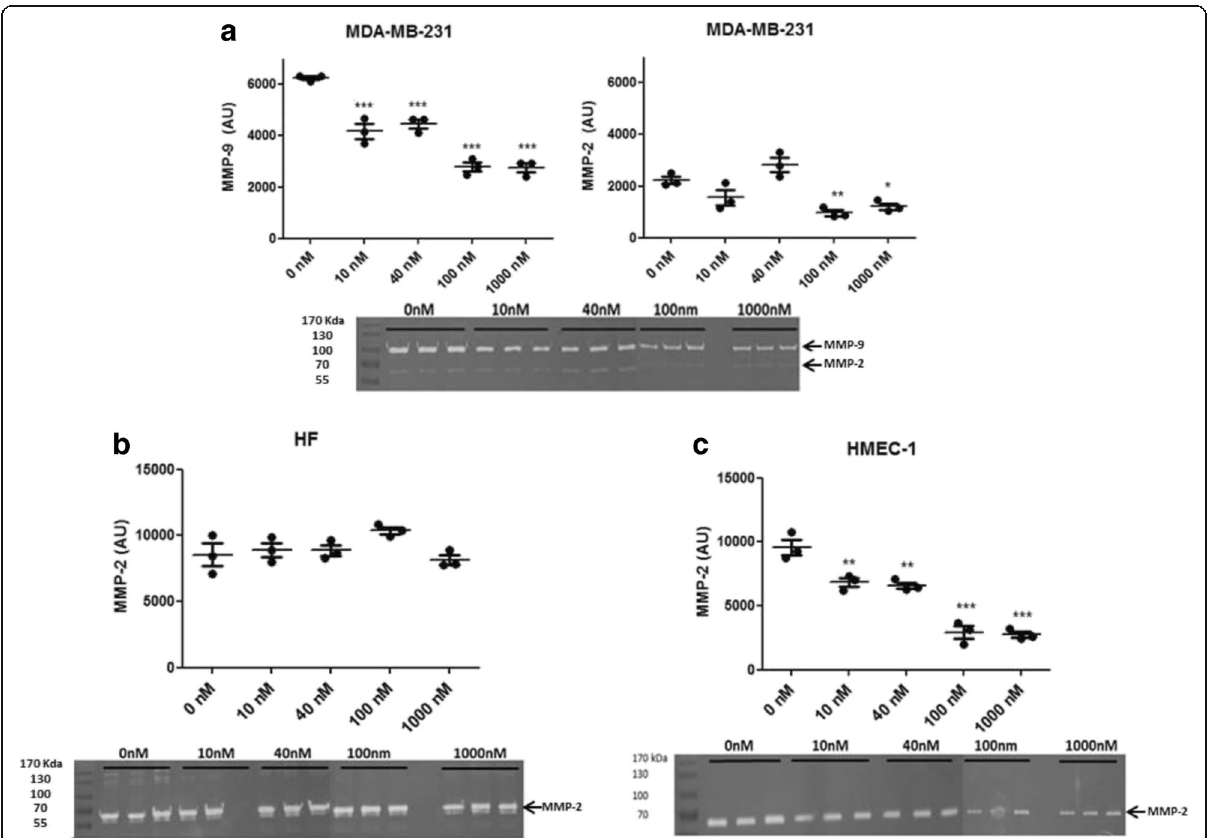
Fig. 4 Effects of ALT-C on the MMP-9 and MMP-2 contents in the conditioned media from ( a ) MDA-MB-231, ( b ) human fibroblasts, and ( c ) HMEC-1 cells. MMP content was detected by band densitometry in the conditioned media (peak area) after wounding and incubation with ALT-C for 24 h. MMP-2 and MMP-9 contents were determined by band densitometry. The assay was performed in triplicate with two independent as- says ( n = 2). * p < 0.05, ** p < 0.01, *** p < 0.001 compared to control (without